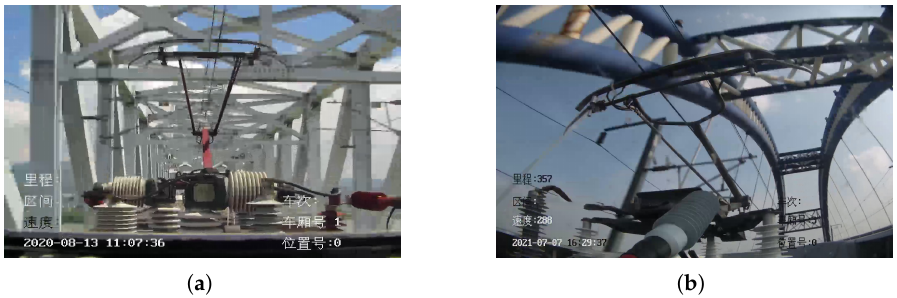
Figure 12. Bride affects pantograph detection. ( a ) HSR-A. ( b )